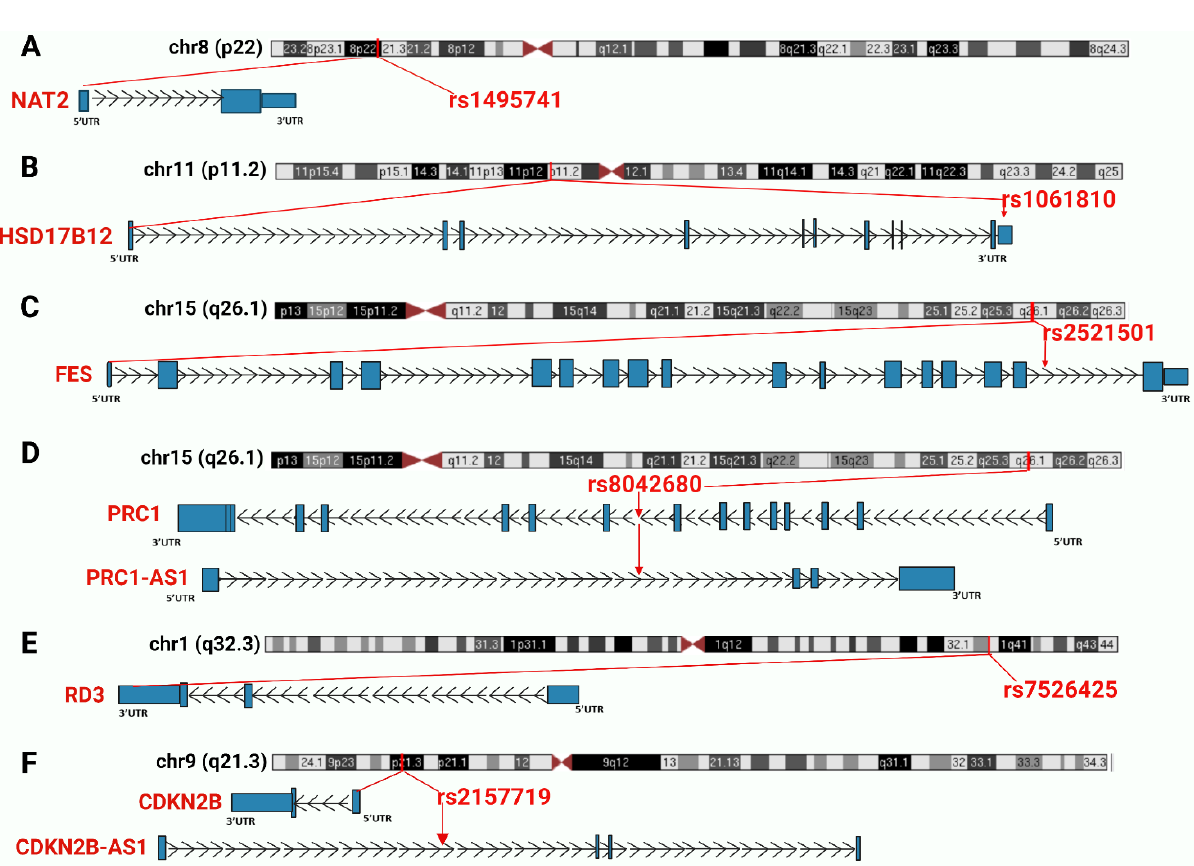
Figure 3. Summary of the chromosomal regions and the nearest genes of the six SNPs jointly associated with T2D and cancer. SNPs and nearest genes are marked in red. Introns are represented as lines with arrows indicating the direction of transcription, while coding exons are represented by blocks. ( A ) NAT2 gene and rs1495741; ( B ) HSD17B12 gene and rs1061810; ( C ): FES gene and rs2521501; ( D ) PRC1 gene, PRC1-AS1 antisense lncRNA and rs8042680; ( E ) RD3 gene and Table 1. Summary of the six SNPs jointly associated with T2D and cancer.